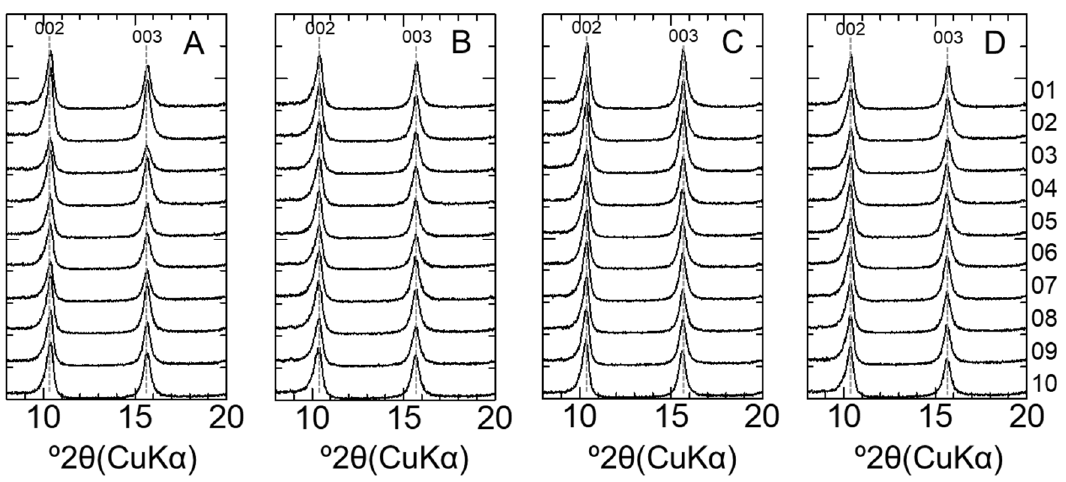
Figure A4. Calcium distribution of OPC-MX_4.9 y (BCI-15).